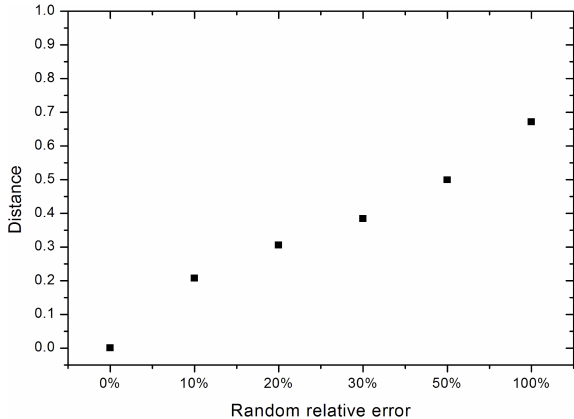
Figure 9. Comparison of the normalized mutual correlation for the linear (LMC) and non-linear cases (MC), calculated for the lidar and radiosonde data sets from the Potenza site.